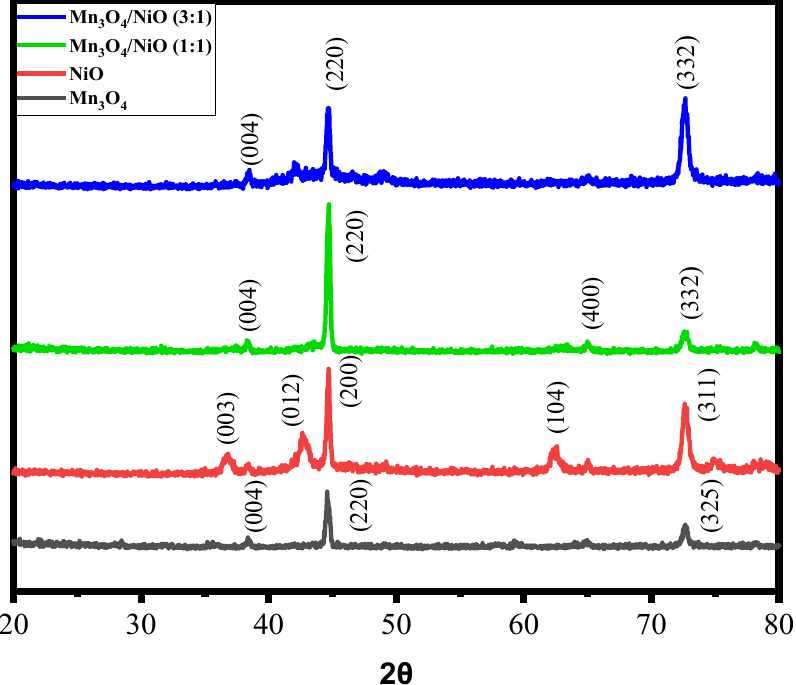
Figure 1. XRD spectra of the Mn 3 O 4 NPs, the NiO NPs, and the Mn 3 O 4 /NiO NCs in different